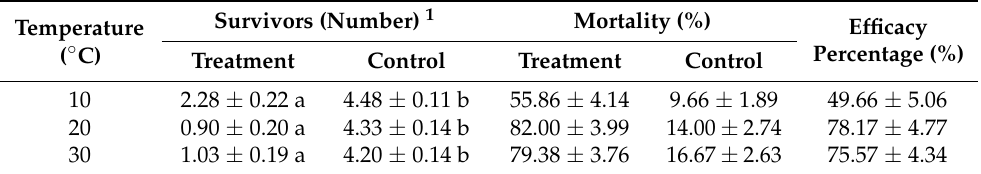
Table 1. Mean values of the number of survivors ( ± SE), mortality percentage ( ± SE) and efficiency percentage, when Phthorimaea operculella eggs were exposed for 48 h to the adult female of the predatory mite Blattisocius tarsalis , in the three bioassays carried out, under laboratory conditions, at three temperatures (10, 20 and 30 ± 1 ◦ C; 80–60% R.H. and 16: 8 h